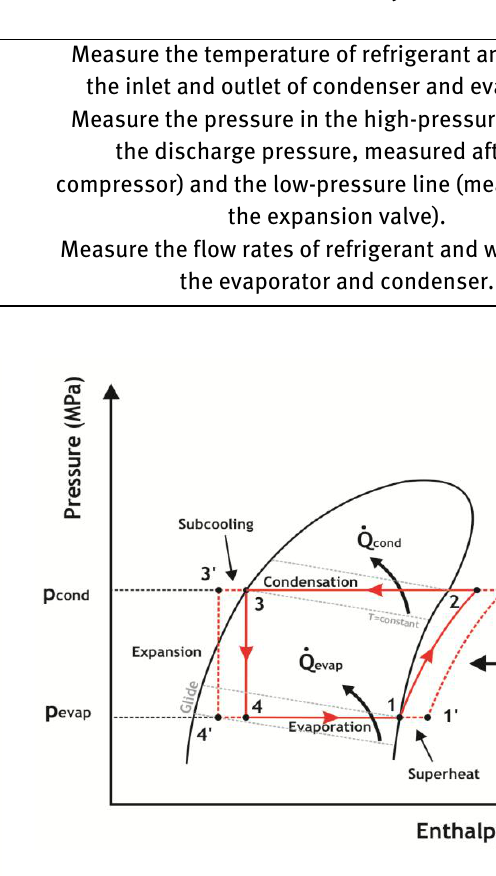
Figure 3: P-h diagram of the vapour-compression refrigeration cycle considered in Fig.